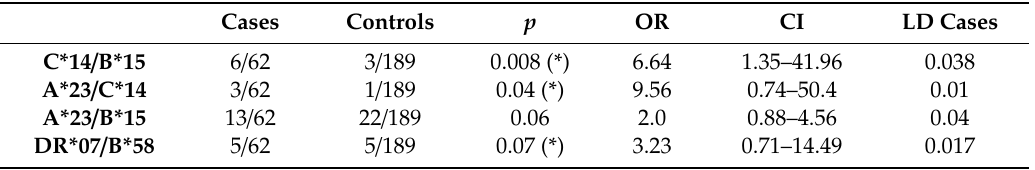
Table 5. Frequency of deducted haplotypes in cases and controls, with OR and CI. (*) indicates Fisher’s test was used. LD: linkage